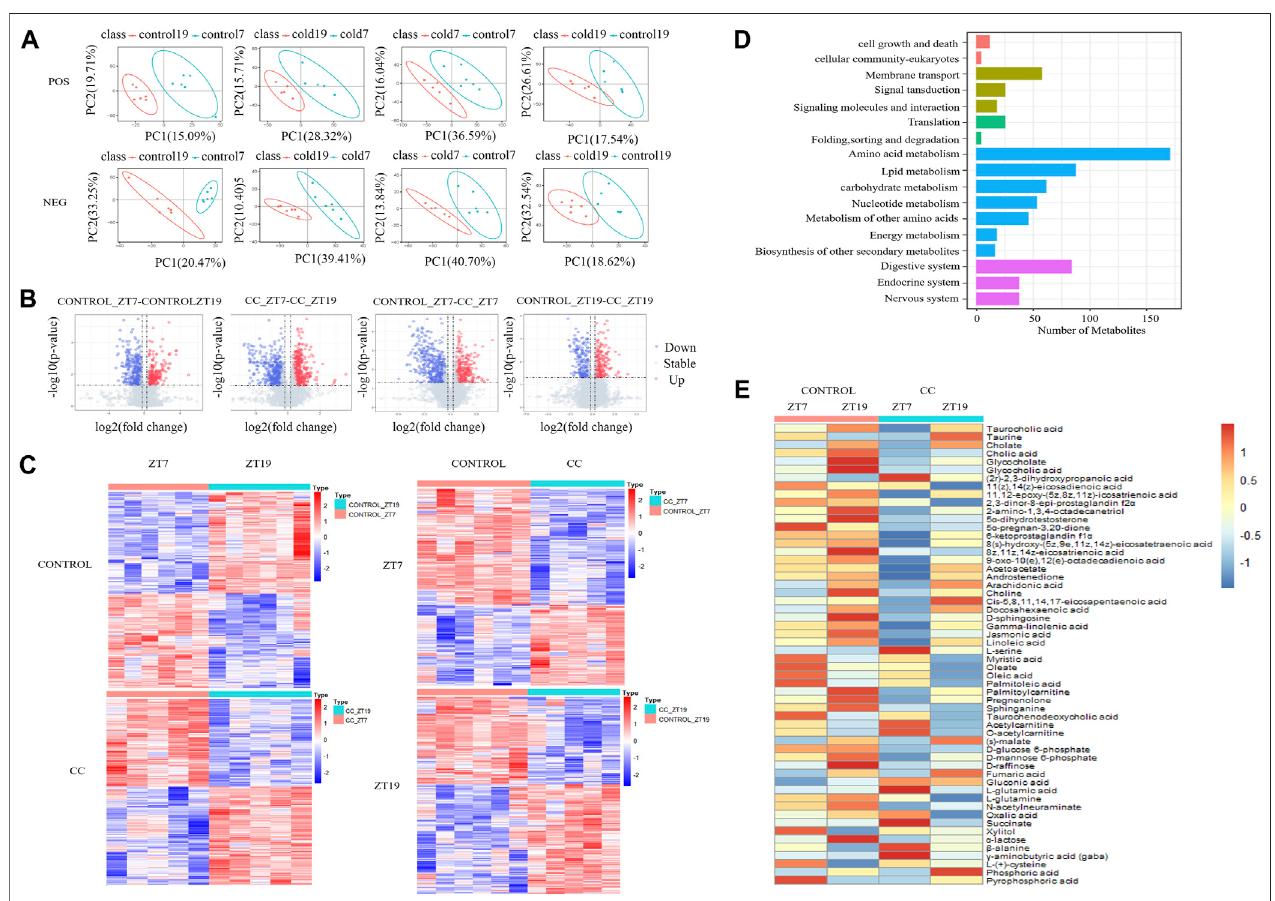
FIGURE 2 | Chronic cold exposure alters the hepatic metabolome. (A) PLS-DA score plots from the control and chronic cold (CC) groups, control ZT7-control ZT19inpositivemode(R 2 =0.98,Q 2 =0.47)andnegativemode(R 2 =0.99,Q 2 =0.83);CCZT7-CCZT19inpositivemode(R 2 =0.97,Q 2 =0.51)andnegativemode(R 2 =0.99, Q 2 =0.69);controlZT7-CC ZT7inpositivemode(R 2 =0.99, Q 2 =0.59)and negative mode (R 2 =0.98,Q 2 =0.56);controlZT19-CCZT19 inpositivemode (R 2 = 0.98, Q 2 = 0.18) and negative mode (R 2 = 0.96, Q 2 = 0.4). (B) Volcano maps for comparing differential metabolites between the control group and the CC group and between ZT7 and ZT19 time points, upregulated metabolites (red dots) and downregulated metabolites (blue dots), and identi fi cation of differential